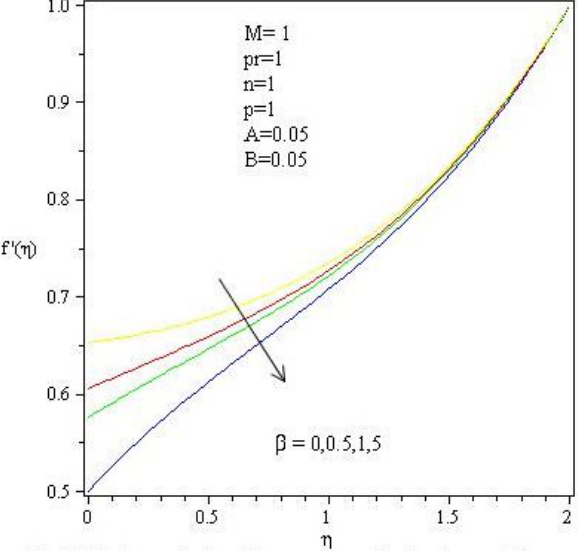
Fig. 8: Velocity profile for different values of β when λ = σ =